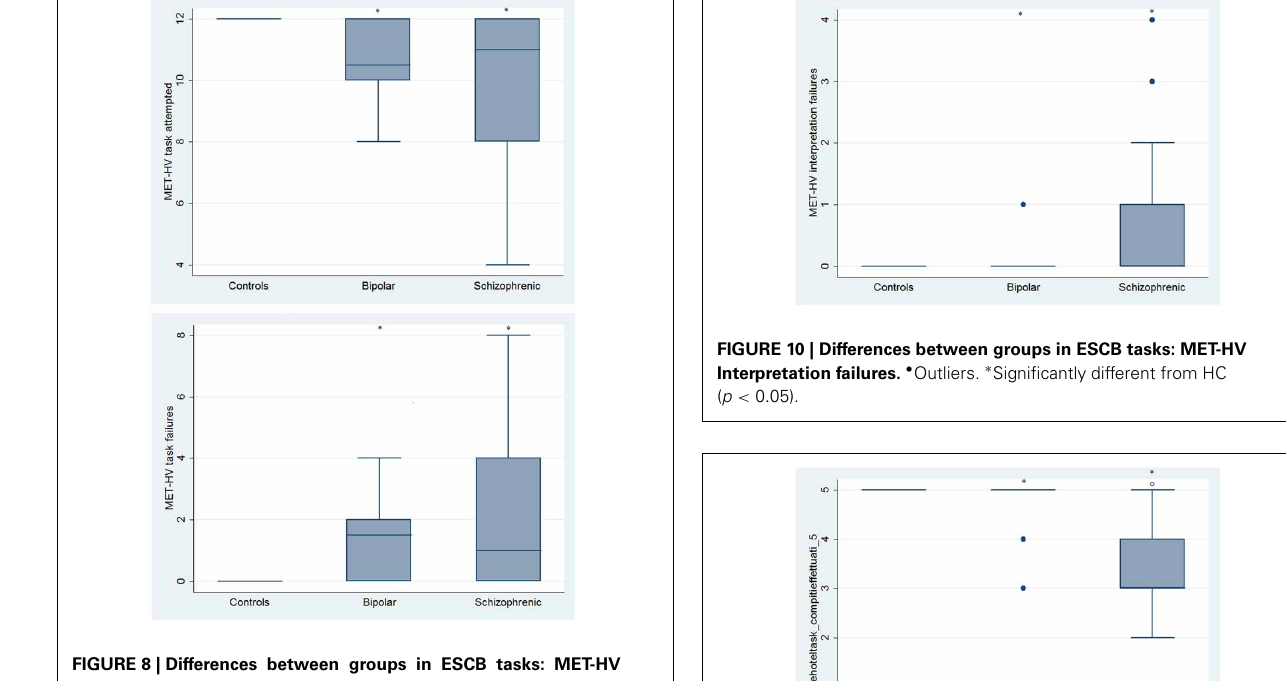
FIGURE 8 | Differences between groups in ESCB tasks: MET-HV Task Attempted and Task Failures. ∗ Significantly different from HC ( p < 0 . 05).